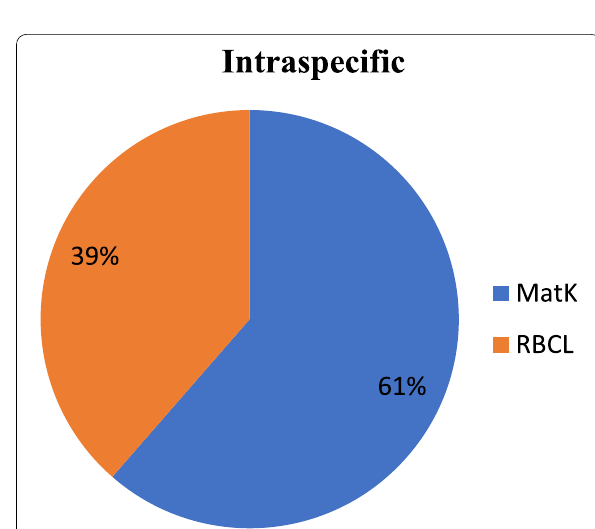
Fig. 9 Interspecific relationships between matK and rbcL and between matK and rbcL gene of twelve accessions of S. tenuifolium and S. vaginatum collected from different